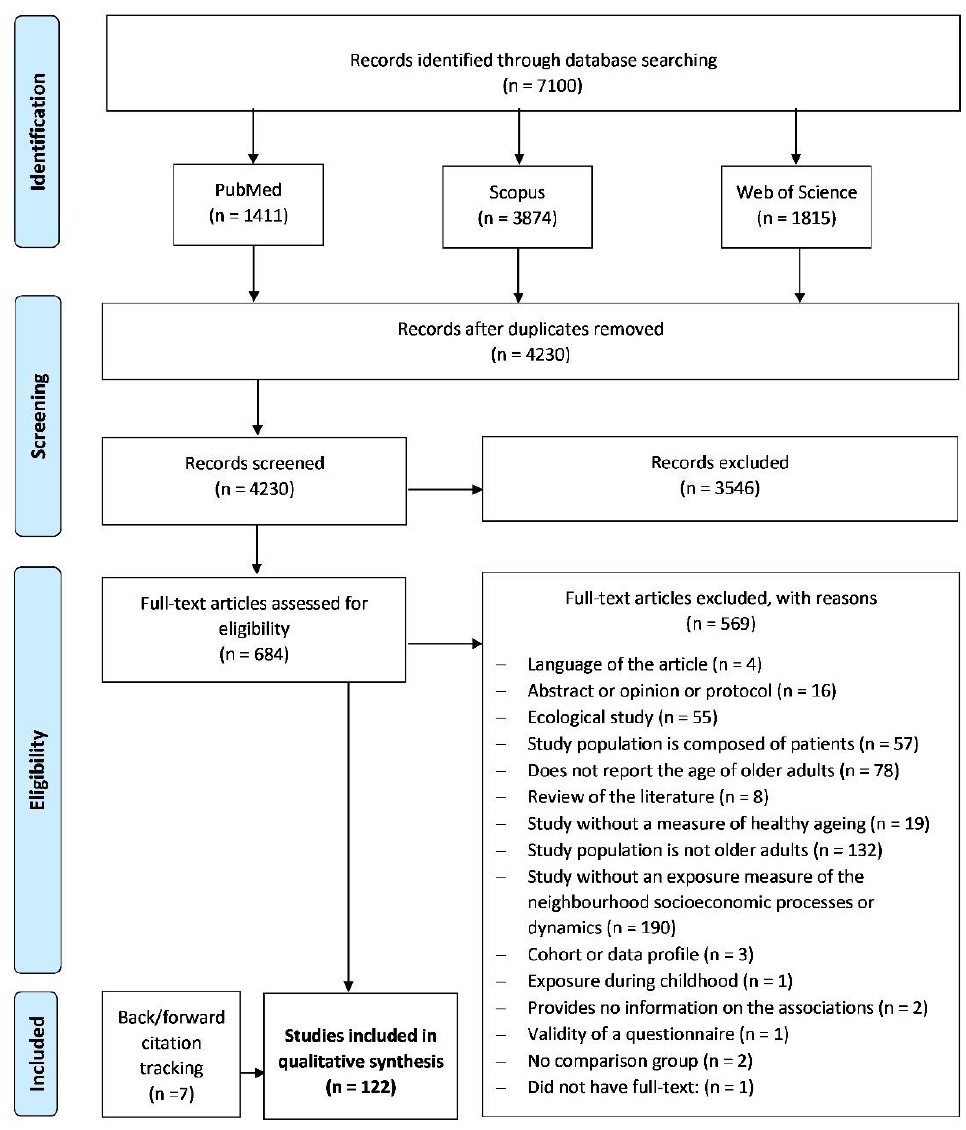
Figure 1. Systematic review flow-chart.